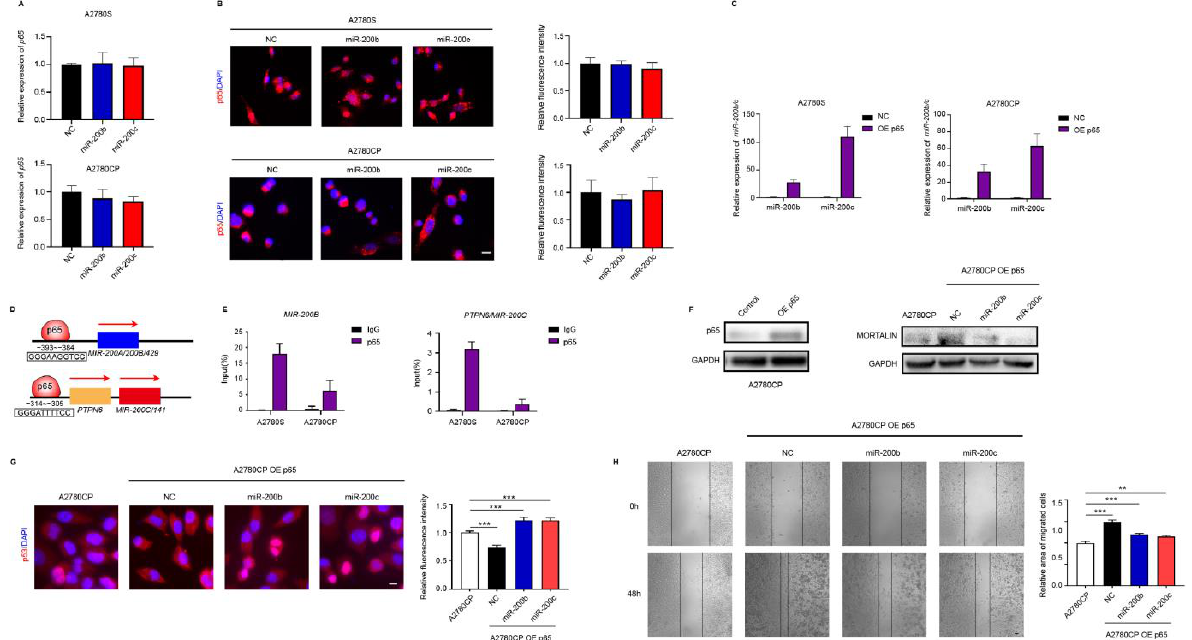
Figure 6. NF- κ B and miR-200b/c co-regulate mortalin expression. ( A ) mRNA expression levels of mortalin were determined via qPCR after transfection of A2780S and A2780CP cells with the miR- 200b/c mimic or NC. ( B ) Nuclear translocation of NF- κ B was detected using immunofluorescence after miR-200b/c transfection (scale bar, 10 µ m). ( C ) Expression levels of miR-200b/c were deter- mined via qPCR after transfection of ovarian cancer cells with the NF- κ B overexpression plasmid. ( D ) Predicted NF- κ B binding site in the promoter region of miR-200b/c . ( E ) ChIP assay was used to detect the binding of NF- κ B to the promoter of miR-200b/c . ( F ) miR-200b/c mimic or NC was transfected into A2780CP NF- κ B stable overexpression cell line, and the protein expression levels of mortalin were determined via Western blotting. ( G ) Nuclear translocation of p53 was detected using immunofluorescence (scale bar, 10 µ m). ( H ) Migration of ovarian cancer cells was determined via transwell assay (scale bar, 50 µ m). Average cell counts of 10 randomly selected fields. Biological replicates (n = 3). ** p < 0.01, *** p <